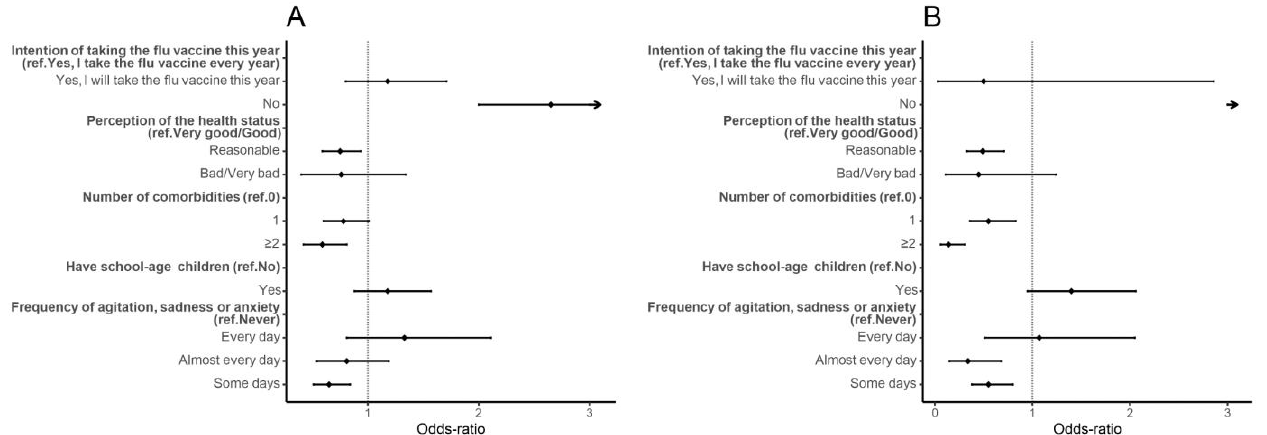
Figure 2. Forest plot of vaccine hesitancy for individual influences. Adjusted odds-ratio (adjusted for gender, age, education, and period of questionnaire) and the respective 95% confidence intervals are denoted by black dots and black lines, respectively. Forest plot confidence intervals and estimates were cut off at 3. ( A ) Results of the main analysis — vaccinated vs. hesitant (refuse, undecided and would take the vaccine); ( B ) results for the sensitivity analysis, removing individuals who would take the vaccine.